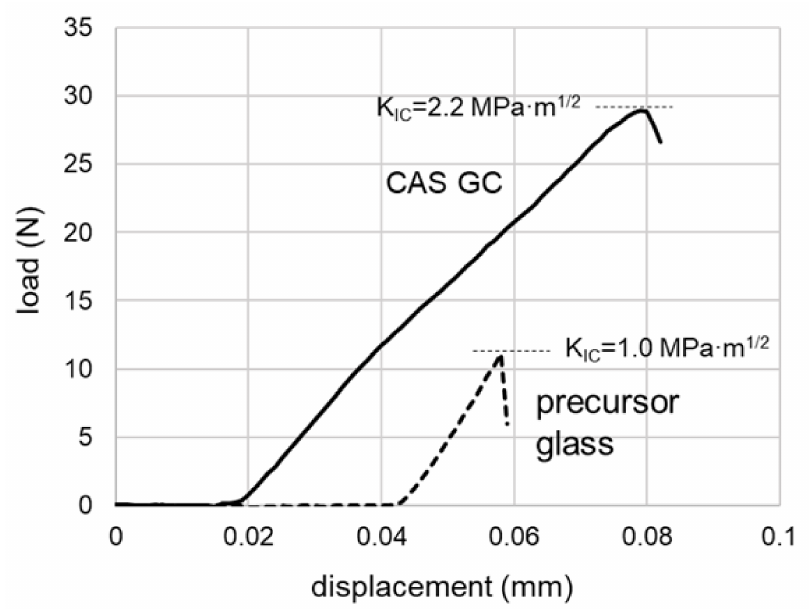
Figure 8. Load–displacement curves of the glasses during the three-point flexural tests [23].